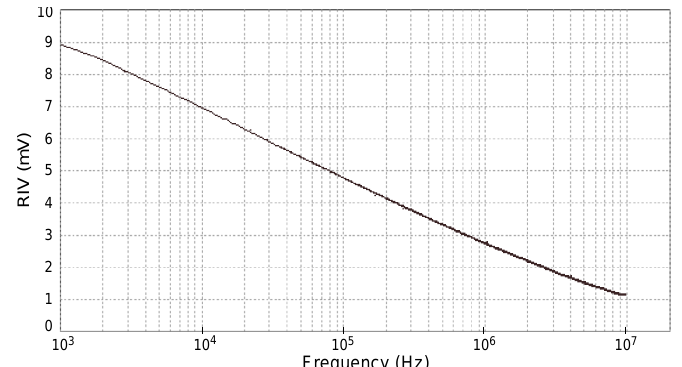
Figure 18. RIV in coupling device for overvoltage on the bushing.